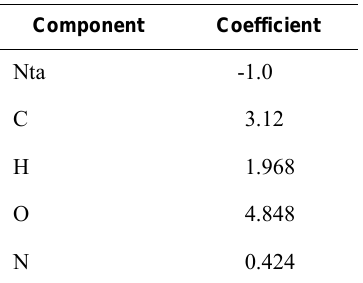
Table 41. Reaction stoichiometry for oxidation of Nta